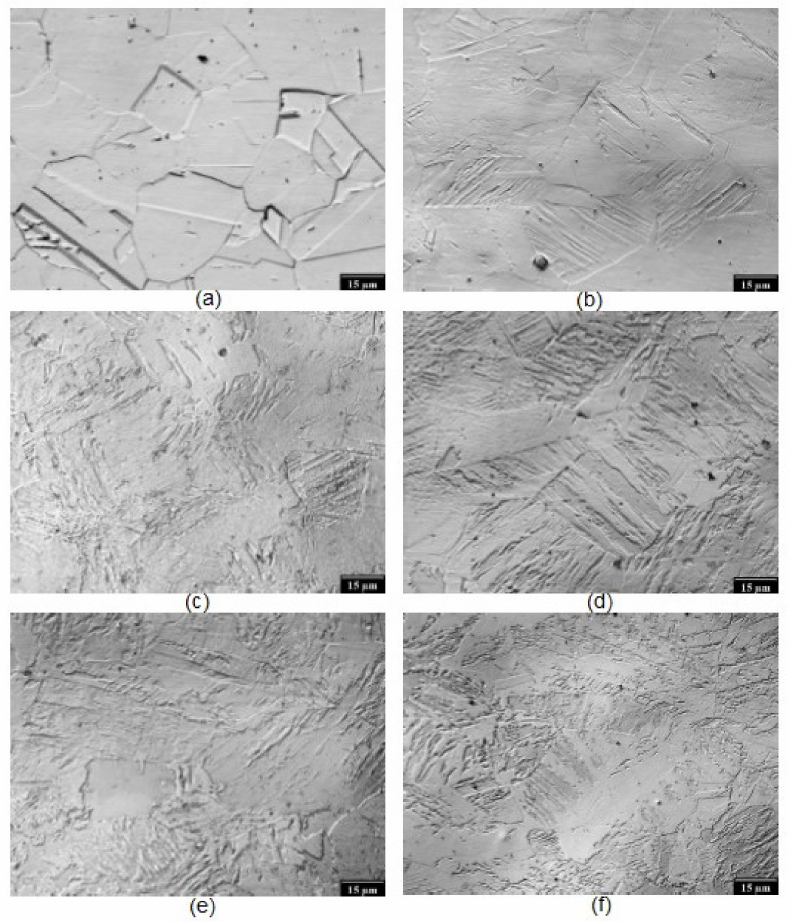
Figure 3. Evolution of microstructure from austenitic to austenitic–martensitic after different levels of plastic pre-straining. ( a ) ε = 5%, ( b ) ε = 25%, ( c ) ε = 35%, ( d ) ε = 45%, ( e ) ε = 55%, ( f ) ε = 60%.